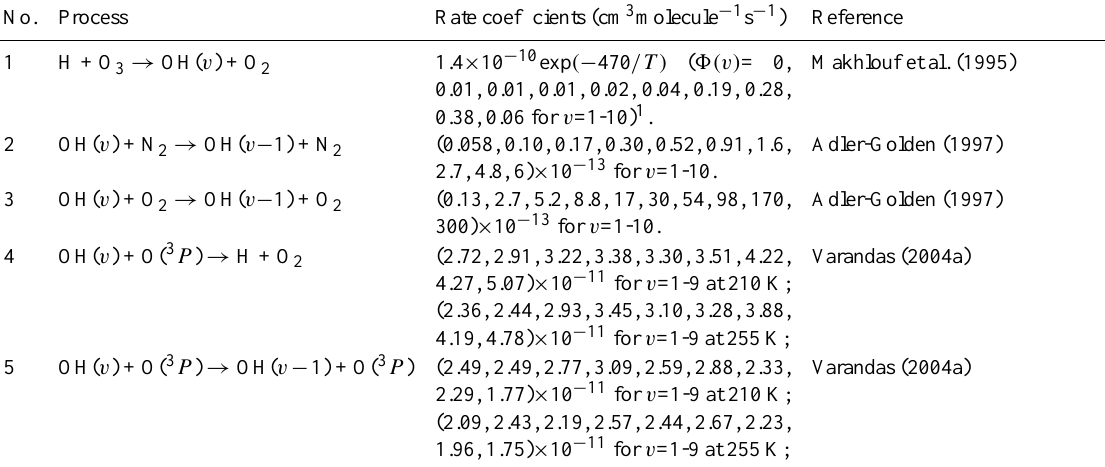
Table 1. Collisional processes included in the OH non-LTE model.